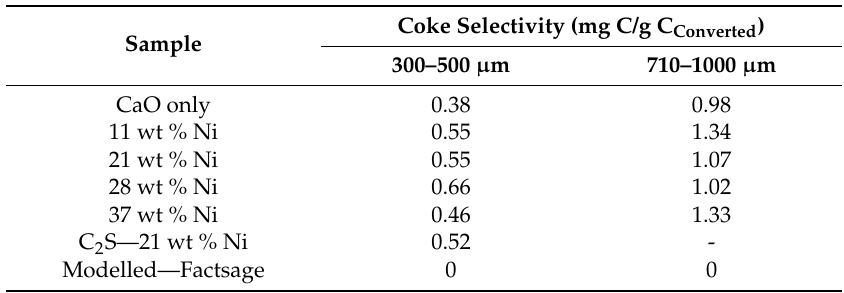
Table 7. Coke selectivity for the various combined particles utilised.